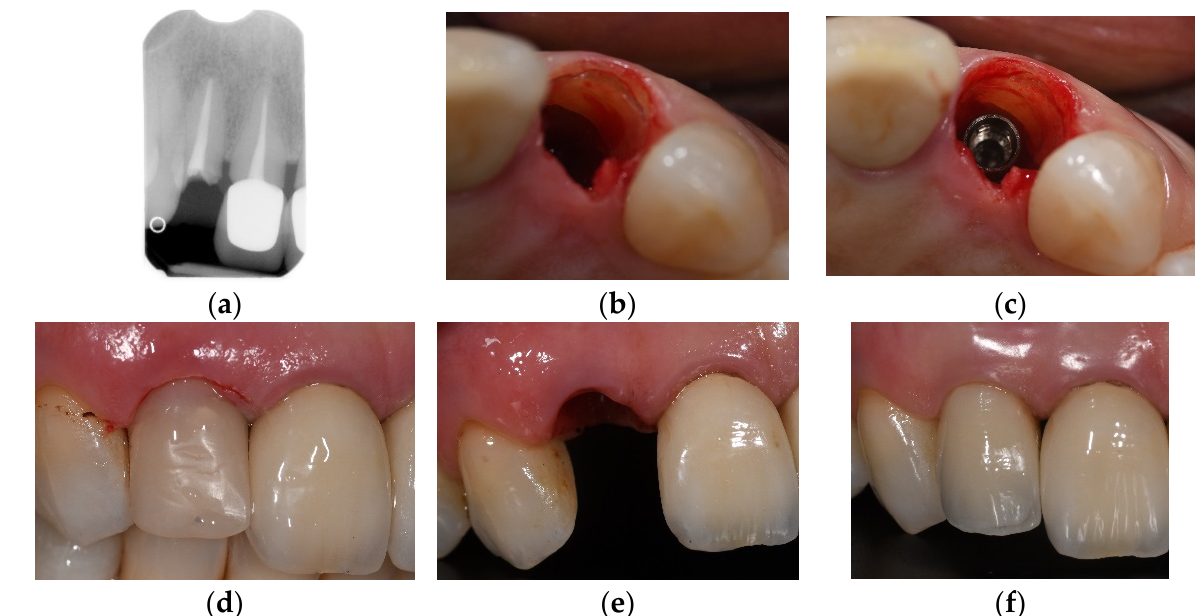
Figure 1. Case of socket shield technique and immediate implant placement. ( a ) the preoperative X-ray shows the absence of apical and/or periodontal infection ( b , c ) the root shield is preserved buccally and slightly more apical from the gingival margin ( d ) temporary crown in acrylic resin- no functional loading ( e ) emergence profile 3 months after the procedure ( f ) one year follow